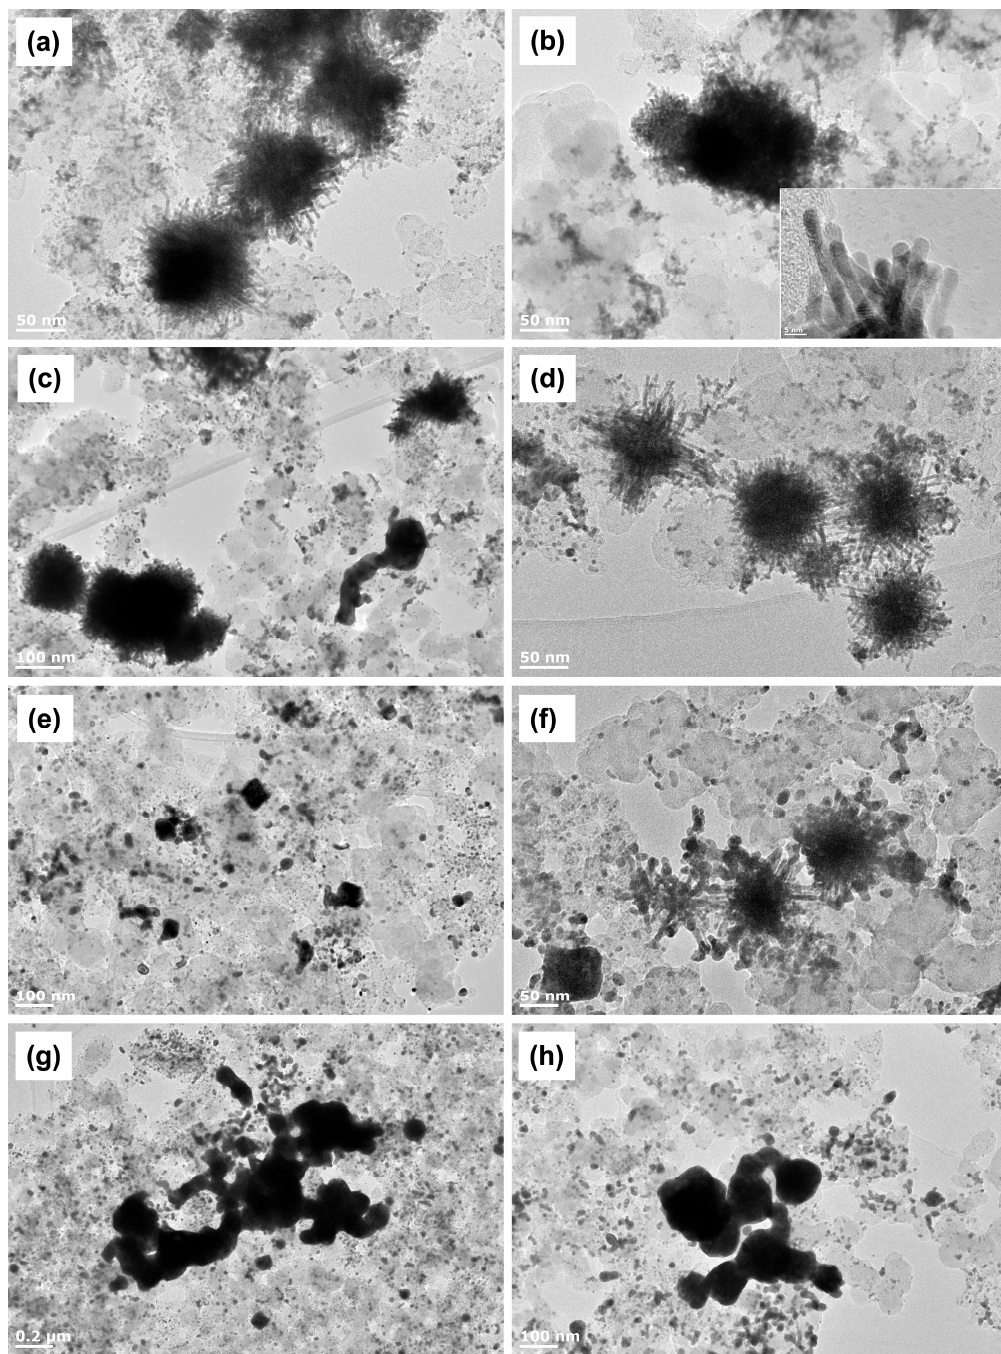
Figure 1. TEM images of ( a ) Pt nanowires (NWs)/C; ( b ) PtNi NWs/C; ( c ) Pt NWs/C (150 °C); ( d ) PtNi NWs/C (150 °C); ( e ) Pt NWs/C (250 °C); ( f ) PtNi NWs/C (250 °C); ( g ) Pt NWs/C (350 °C); and ( h ) PtNi NWs/C (350 °C). Inset 1b show the HR-TEM images of the PtNi NWs.